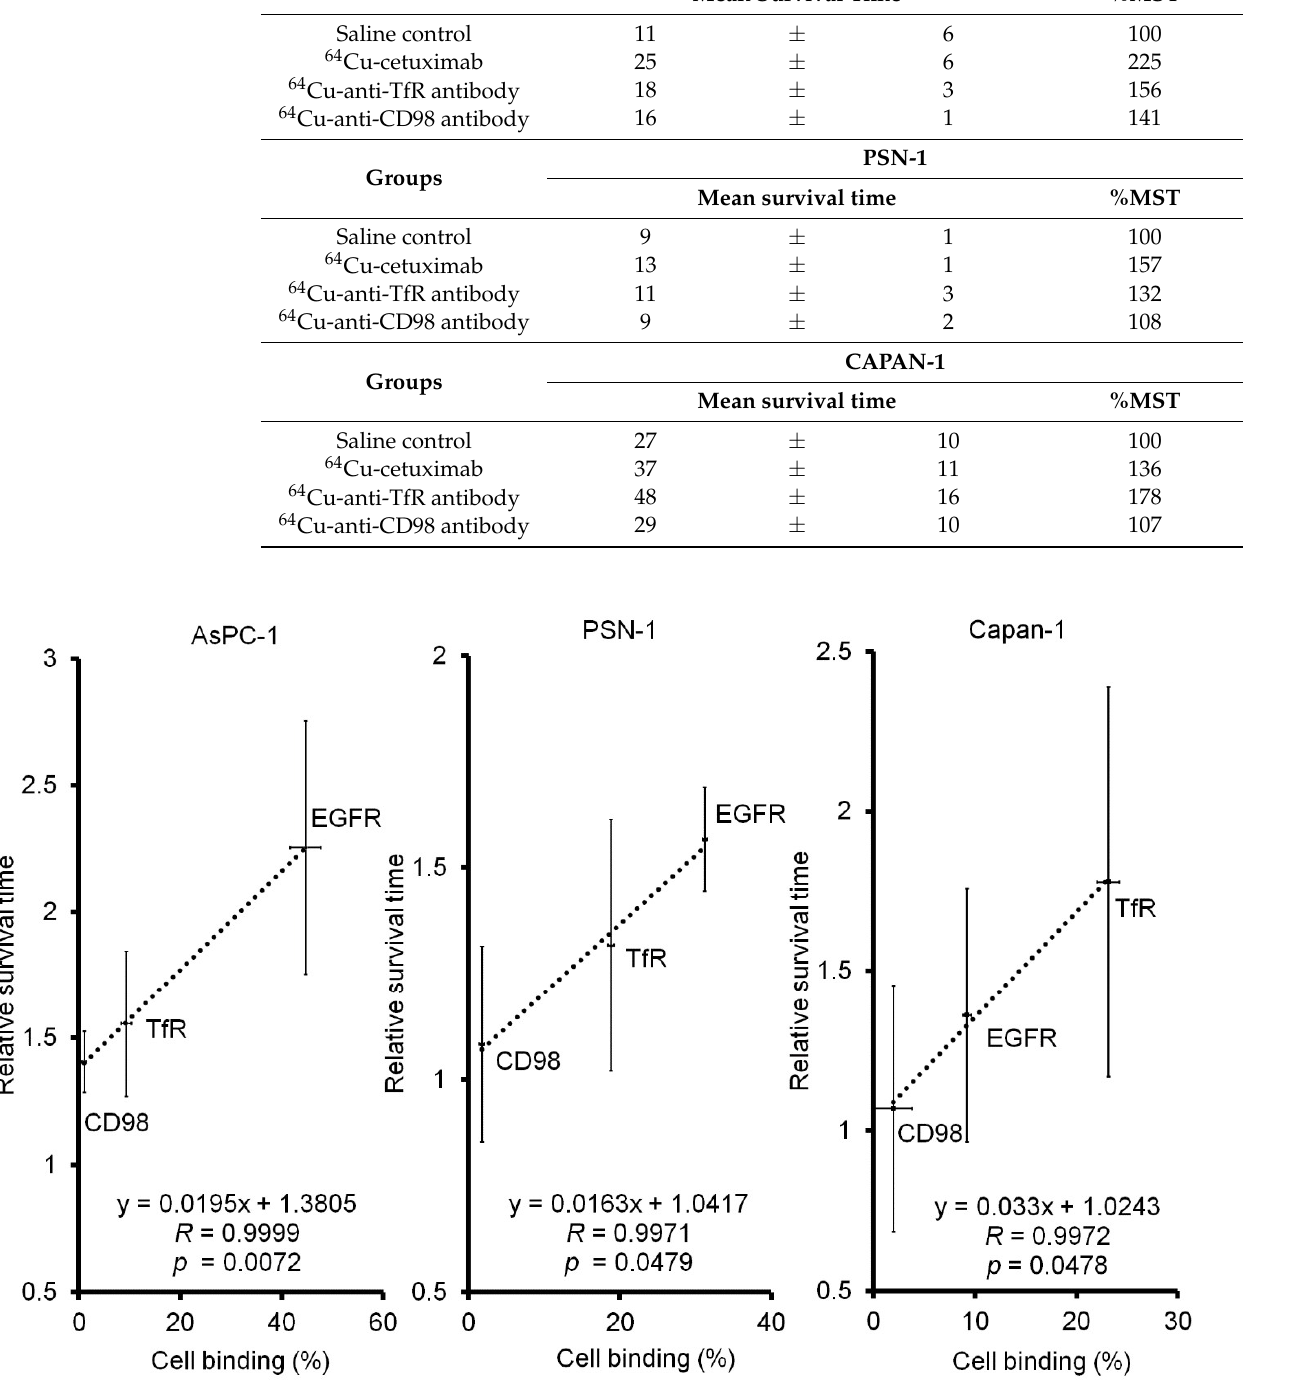
Figure 5. Relationships between in vitro cell-binding assay and in vivo treatment study. Correlation between cell binding (%) from the in vitro study and relative survival time from the in vivo study in AsPC-1 (left), PSN-1 (middle), and Capan-1 (right). Table 2. Mean survival time (MST) from in vivo treatment study in the peritoneal dissemination mouse models of AsPC-1, PSN-1, and Capan-1 cell lines.